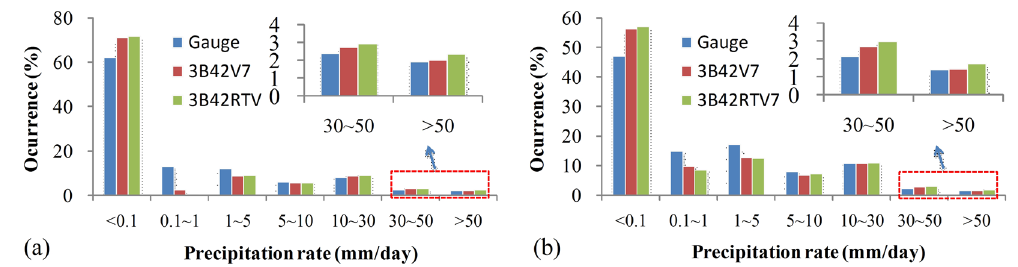
Figure 5. The probability distribution of the grid-based daily precipitation ( a ) and average daily precipitation ( b ) from the three precipitation products indicated.